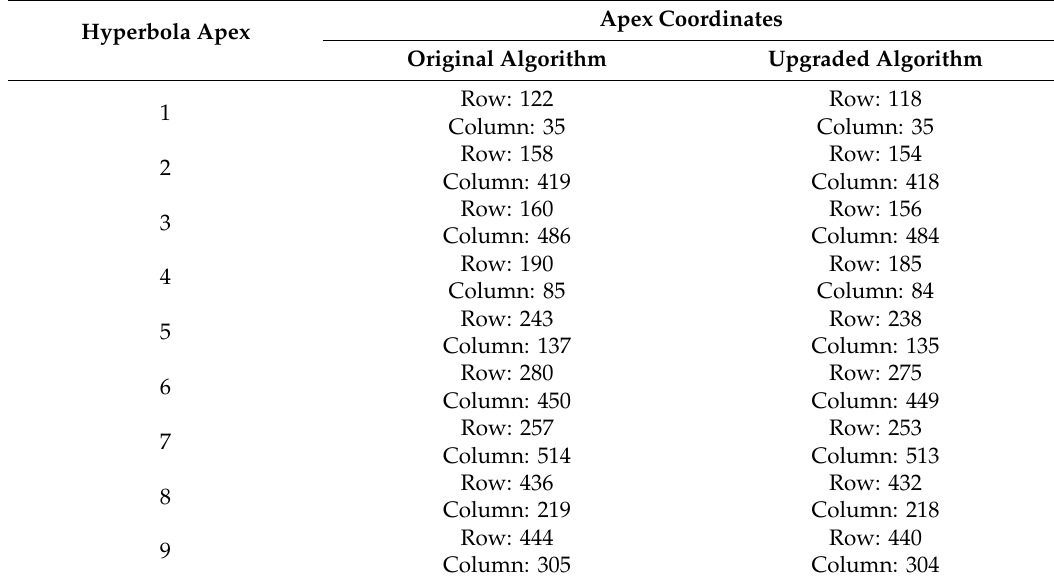
Table 3. Coordinates of hyperbola apices (in terms of pixels) found in Radargram #8 by using the original and upgraded versions of the APEX